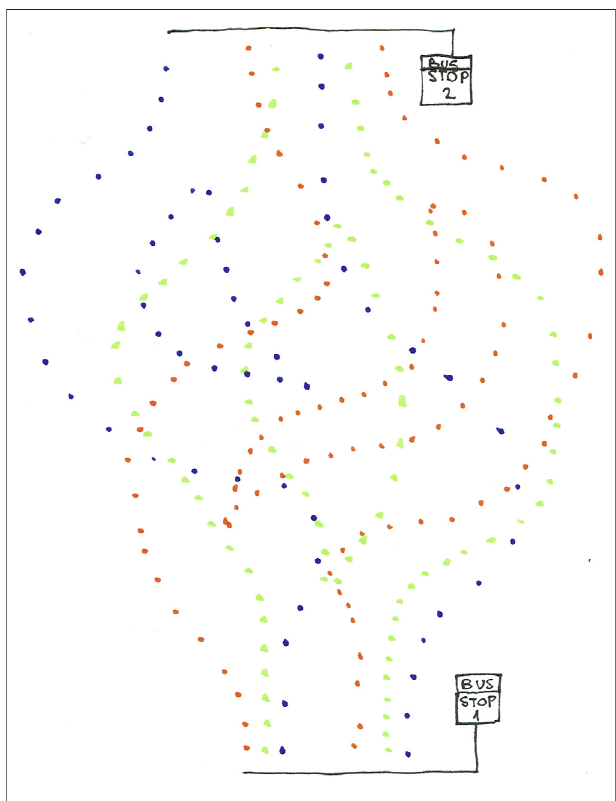
FIGURE 4 | Invisible